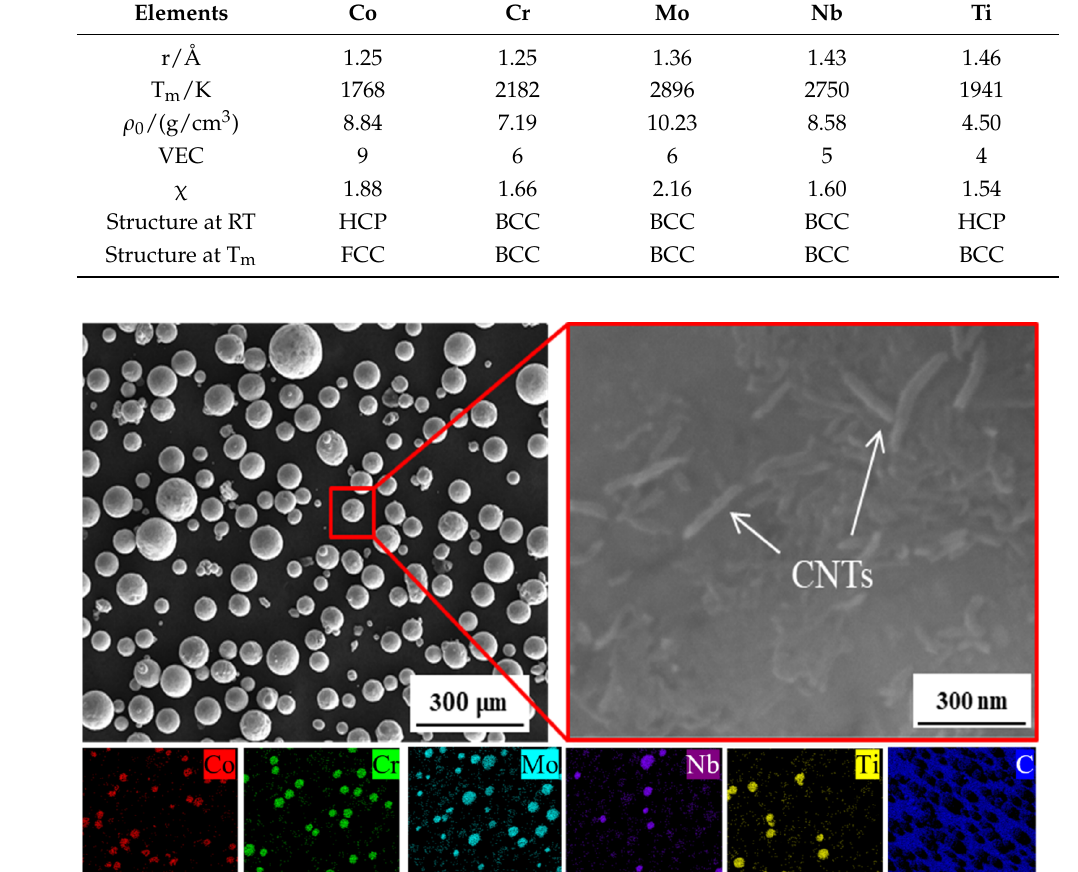
Figure 1. SEM image showing the morphology of 0.8 wt.% CNTs/CoCrMoNbTi 0.4 mixed powder after ball milling.